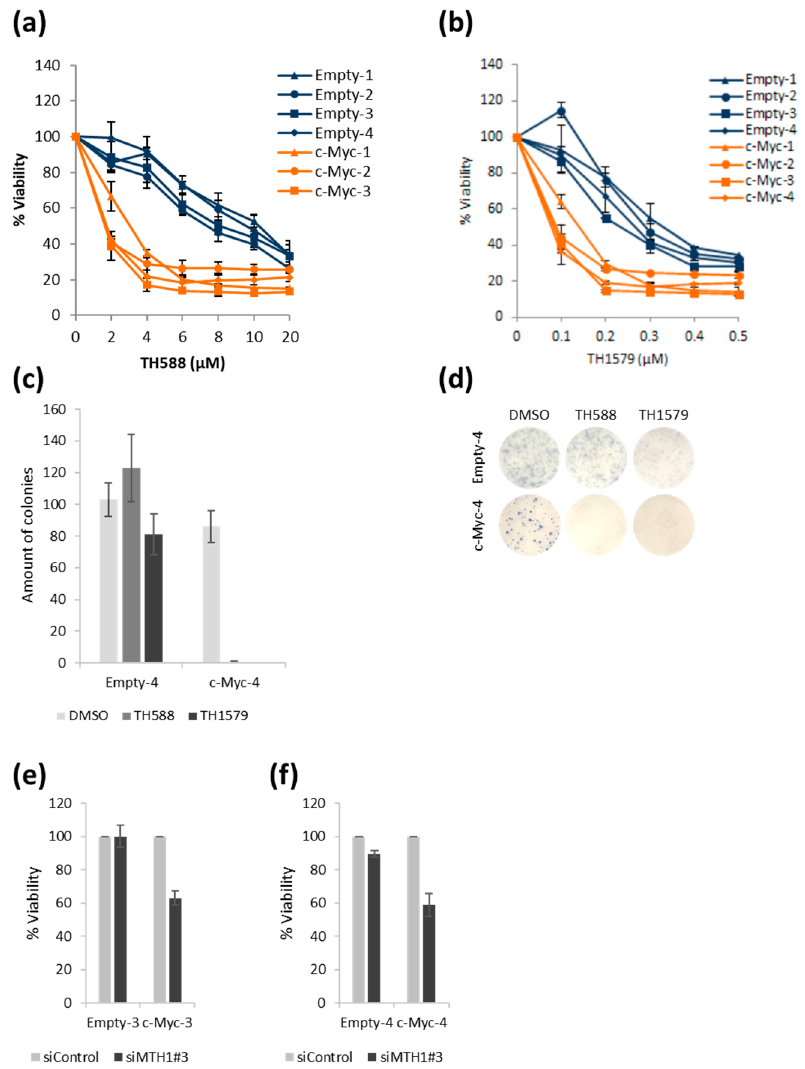
Figure 4. Viability of c-Myc overexpressing cells is decreased upon TH588 or TH1579 treatment or MTH1 silencing. ( a , b ) Empty and c-Myc overexpressing cells were plated and treated with the indicated concentrations of TH588 or TH1579 (or DMSO). After 72 h, 10 µ g/mL resazurin was added for 4 h and viability was determined (values are normalized to DMSO), n = 3 ( a ), n = 2 ( b ) ± S.E.M. ( c ) Empty-4 and c-Myc-4 cells were seeded, immediately treated with 5 µ M TH588 or 0.5 µ M TH1579 for 48 h, new media were added every 2–3 days until colony staining (9–10 days after seeding). The values were normalized to DMSO control, n = 2 ± S.E.M. ( d ) Representative clonogenic survival assay images of Empty-4/c-Myc-4 cells. ( e , f ) Cells were seeded and transfected with 10 nM siRNA. After 72 h, 10 µ g/mL resazurin was added for 4 h and viability was determined (values are normalized to siControl), ( e ) n = 3, ( f ) n = 2 ±